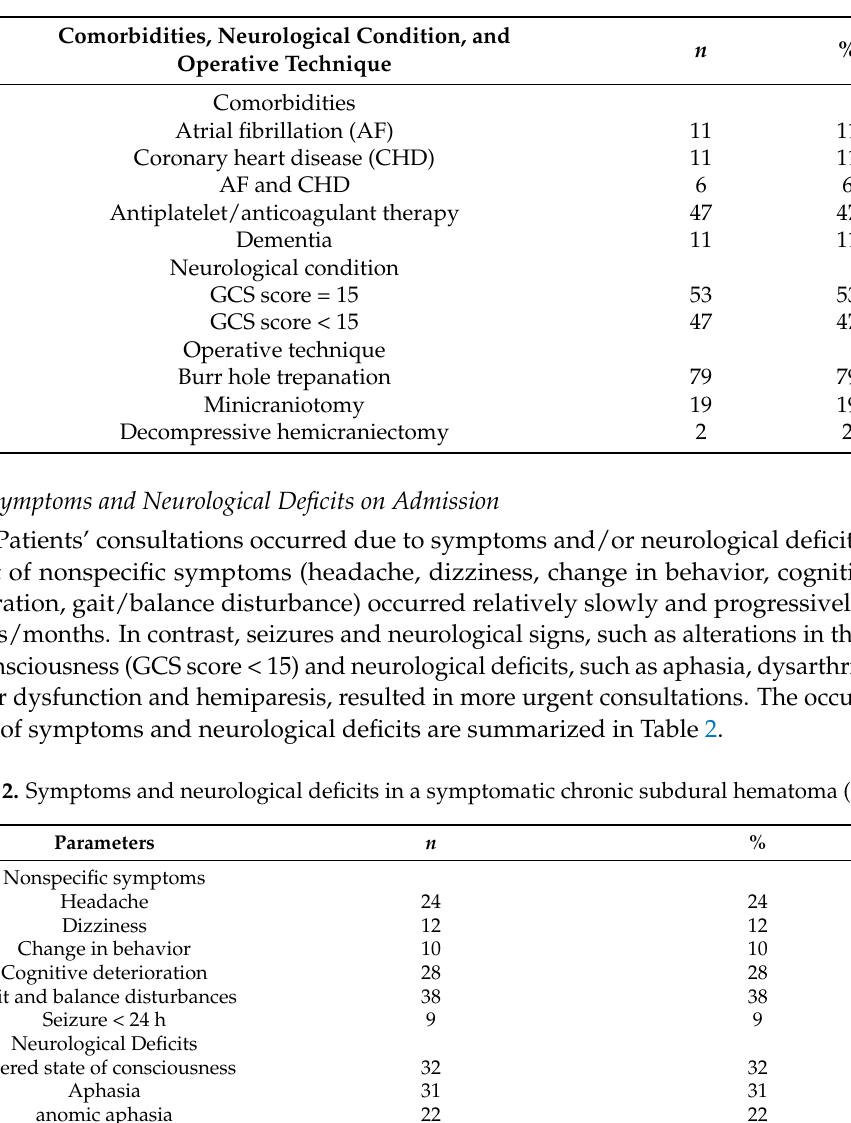
Table 1. Patient characteristics and operative technique.